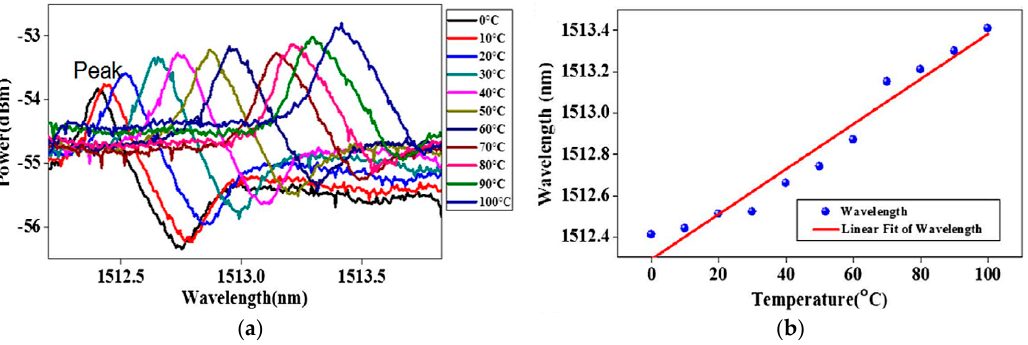
Figure 13. ( a ) Relationship between the Fano resonant output power and wavelength at different temperatures; ( b ) relationship between the wavelength of the Fano resonator and temperature. [Reprinted/Adapted] with permission from ref [39], [OSA].